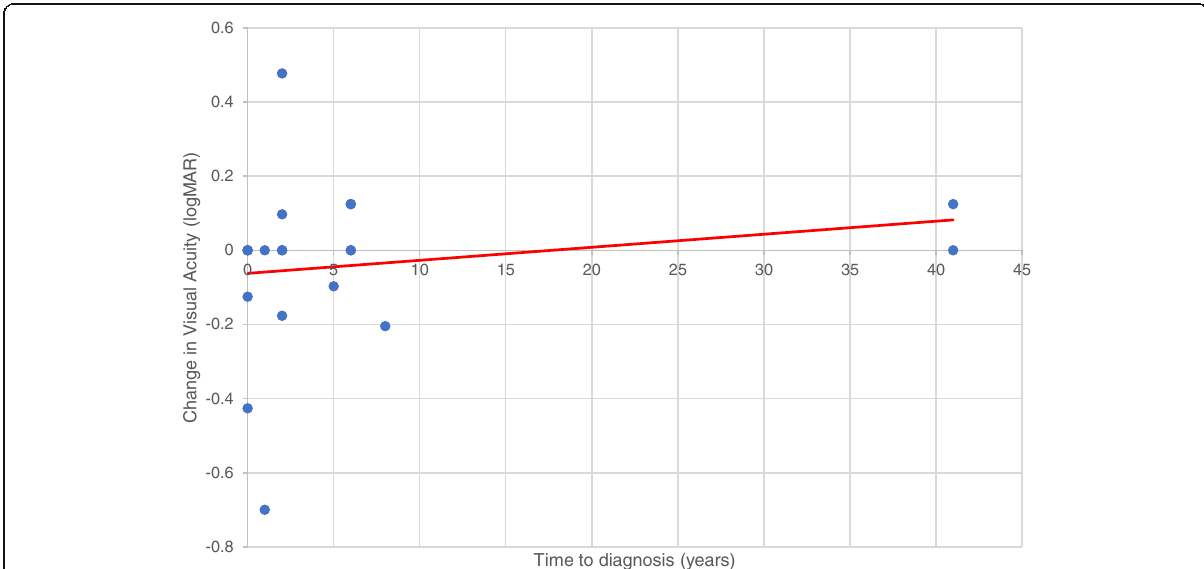
Fig. 1 Change in visual acuity between baseline and last follow-up visit in logMAR units demonstrates a slight trend of worsening vision with delay in the time to diagnosis